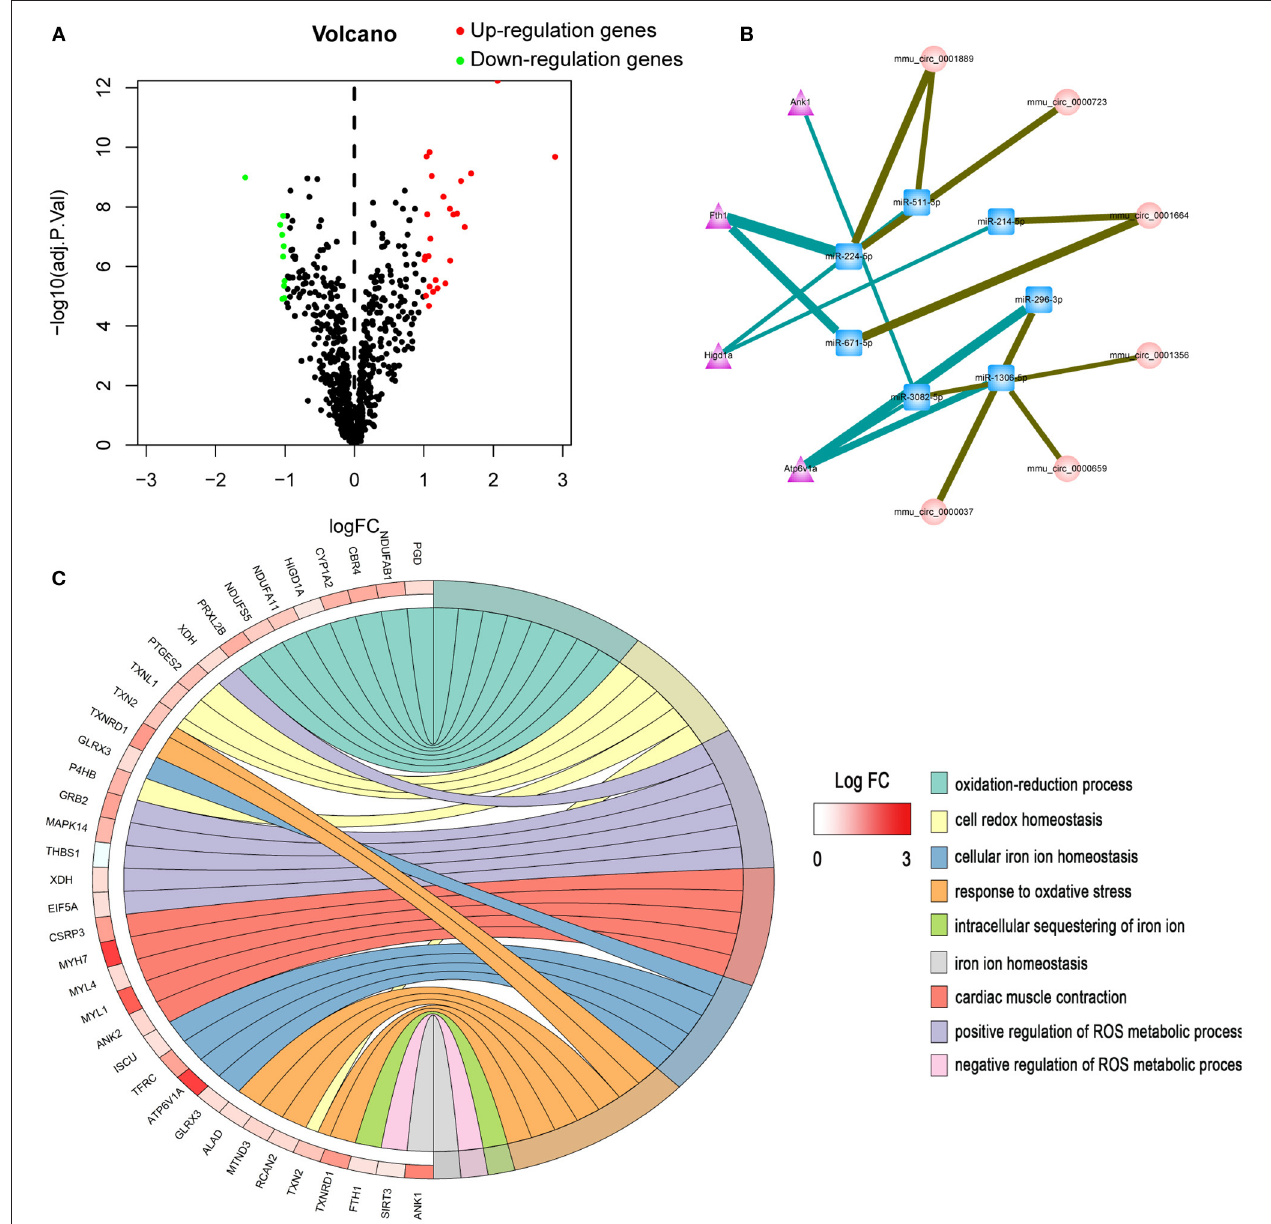
FIGURE 1 | Bioinformatics analysis of differentially expressed genes. (A) Volcano plot of differentially expressed miRNAs. (B) The circRNA-miRNA-mRNA competing endogenous RNA network. The triangle nodes represent mRNAs in purple, circular nodes indicate circRNAs in pink, and square nodes represent miRNAs in blue. The thicker the edge, the higher the weight score of the interaction. (C) GO enrichment analysis of differentially expressed